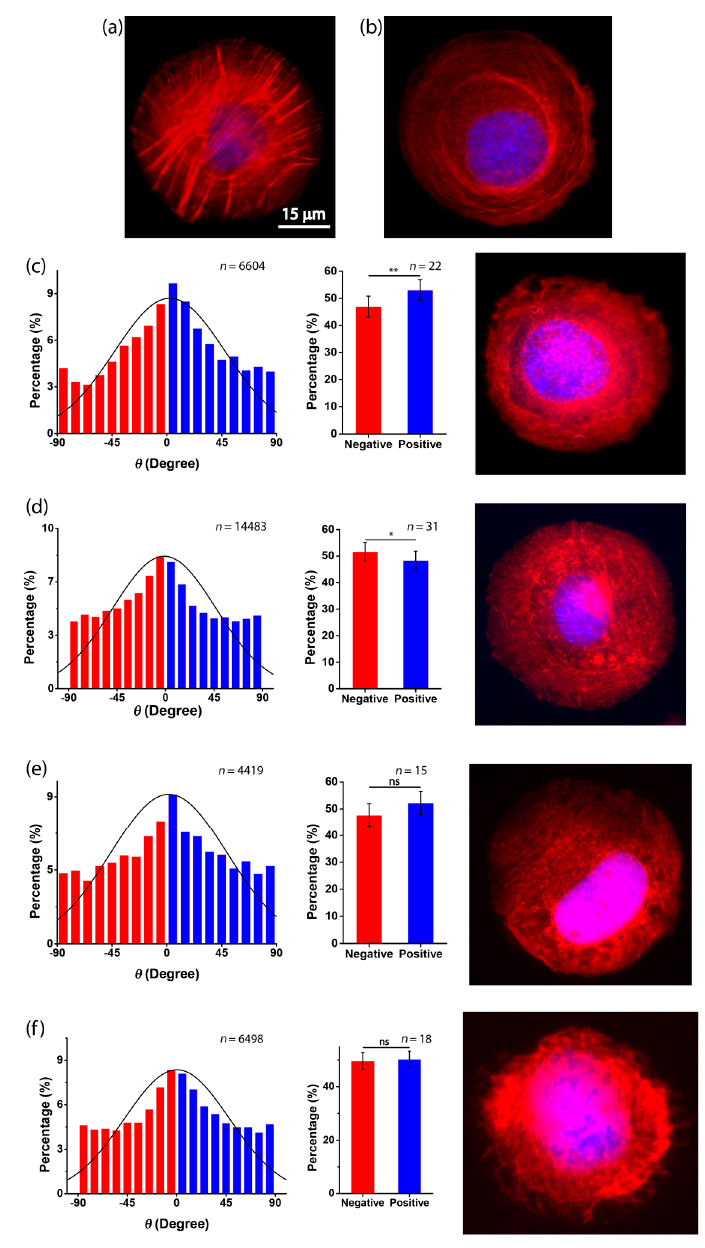
Figure 5. Assembly of actin filaments is required for cell chirality. ( a , b ) Fluorescence microscopy images of actin filaments of untreated C2C12 myoblasts cultured in circular micropatterns on a glass substrate ( a ) or a PDMS substrate (ratio of elastomer to cross-linker = 30:1) ( b ); ( c , d ) fluorescence microscopy images of actin filaments of C2C12 myoblasts cultured in circular micropatterns on a glass substrate and the histogram of cell orientation when cultured in micropatterned stripes on a glass substrate with the presence of Cytochalasin D ( c ) or Y27632 ( d ); ( e , f ) fluorescence microscopy images of actin filaments of C2C12 myoblasts cultured in circular micropatterns on a PDMS substrate (ratio of elastomer to cross-linker = 30:1) and the histogram of C2C12 orientation cultured in micropatterned stripes on a PDMS substrate (ratio of elastomer to cross-linker = 30:1) with the presence of Cytochalasin D ( e ) or Y27632 ( f ).